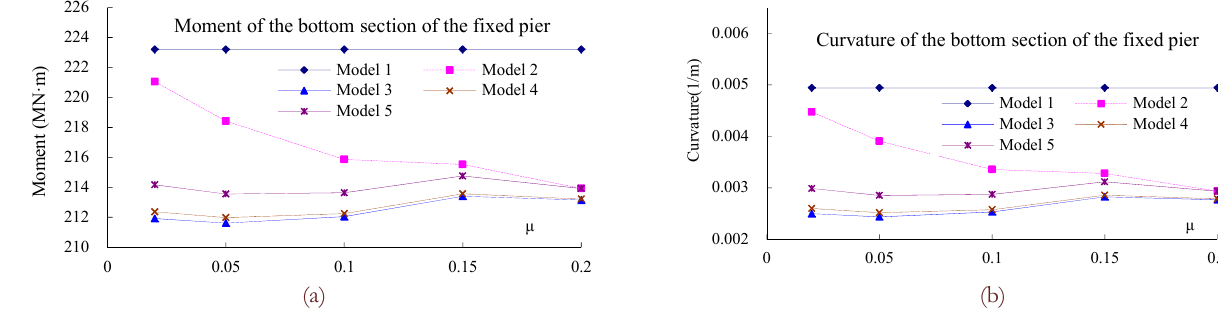
Figure 7: Moment and curvature of the bottom section of the fixed pier under the first artificial seismic wave.